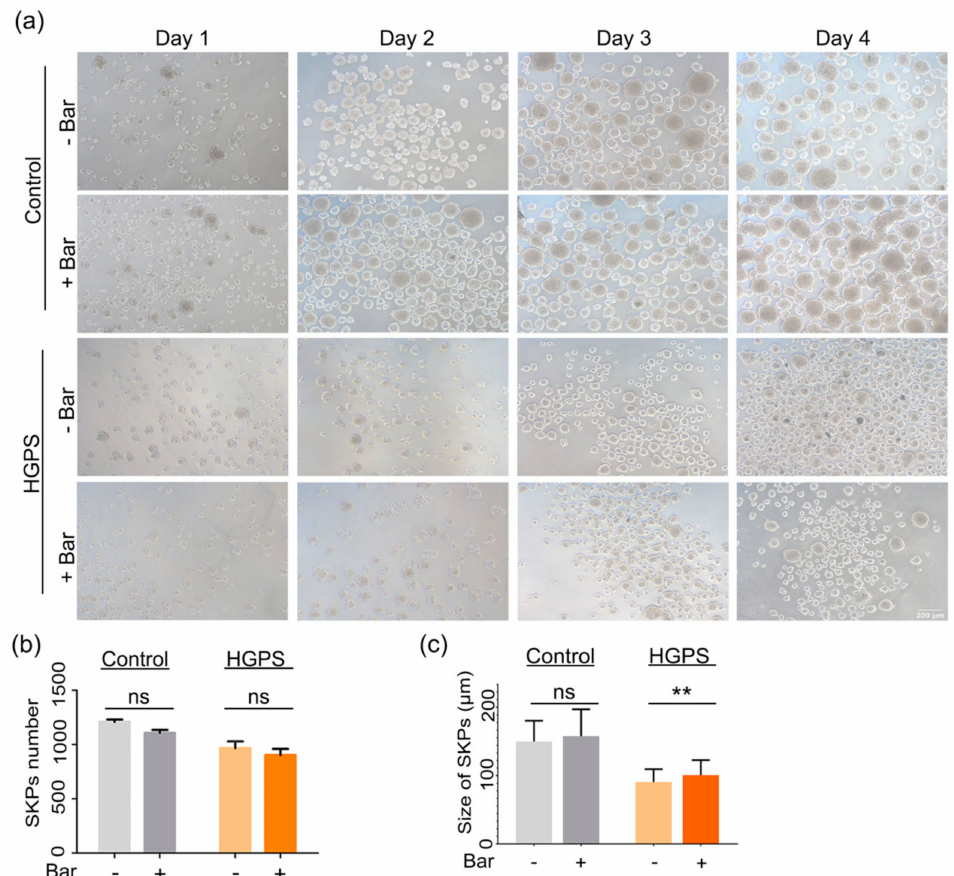
Figure 6. SKPs characterization after treatment with baricitinib. ( a ) SKPs isolation from control (GMO5567A) and HGPS (HGADFN127) fibroblasts after treatment with baricitinib (Bar). ( b , c ) Quantification of the number and average size of SKPs in control and HGPS groups with or without baricitinib treatment. Values are presented as mean ± SD ( n = 3), not significant (ns), ** p < 0.01, ( b , c ) unpaired t